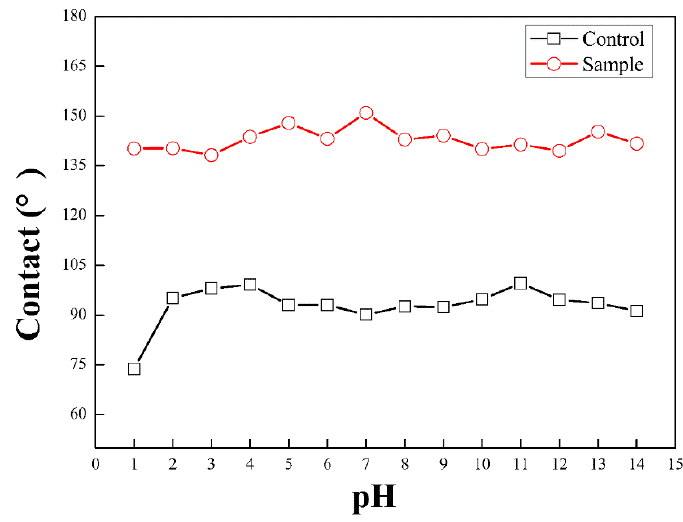
Figure 6. Comparison of different pH environments contact angle of structured Q235 carbon steel and superhydrophobic Q235 carbon steel.